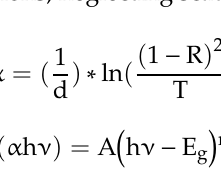
Table 3. Electrical resistivity of the CMTS thin films deposited at different substrate temperatures.